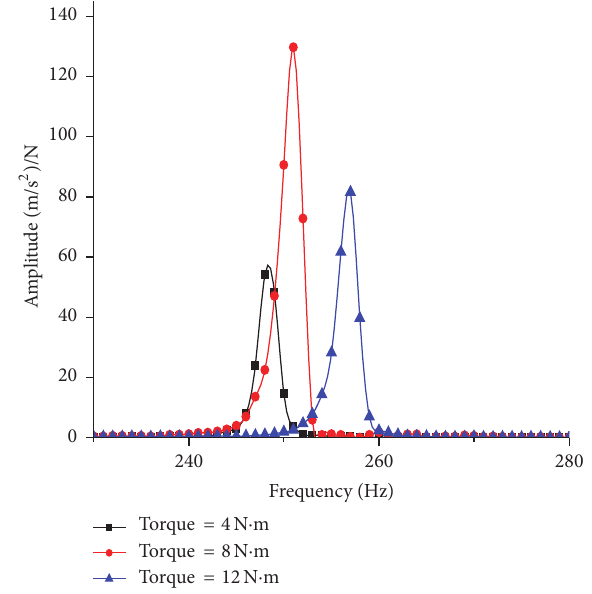
Figure 20: Frequency response functions of the second mode with impact levels 𝐹 exc = 200